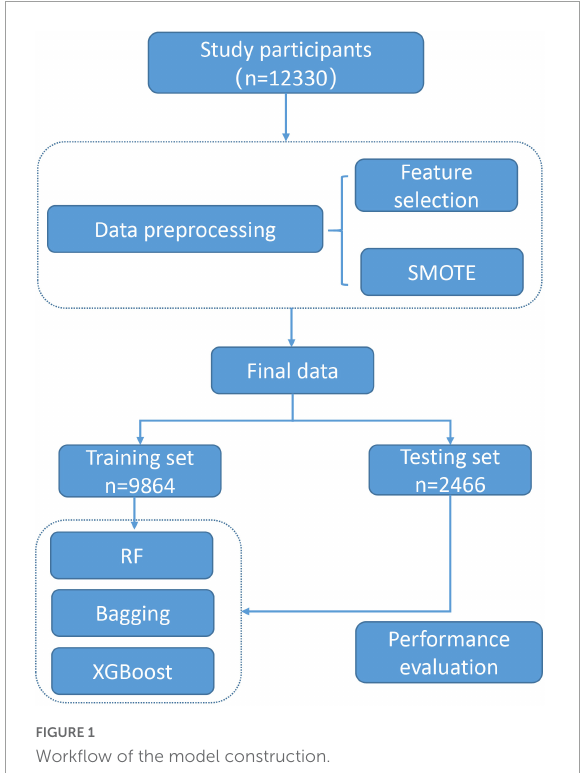
FIGURE1 Workflow of the model